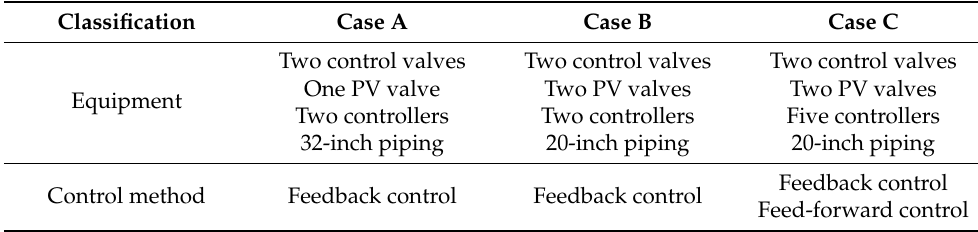
Table 1. A summary of each case